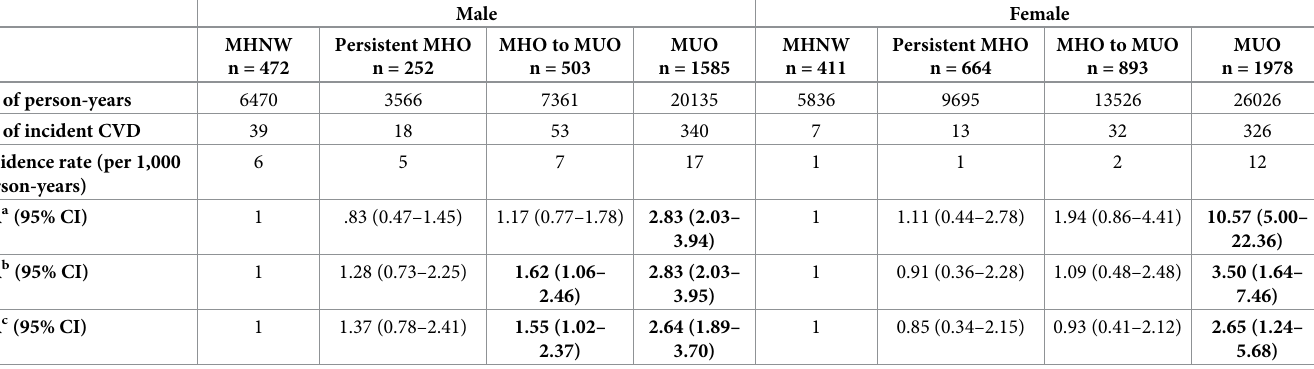
Table 2. Hazard ratios (HRs) for incident cardiovascular disease in 6758 study participants according to obesity phenotypes at baseline and through 15-years of fol-